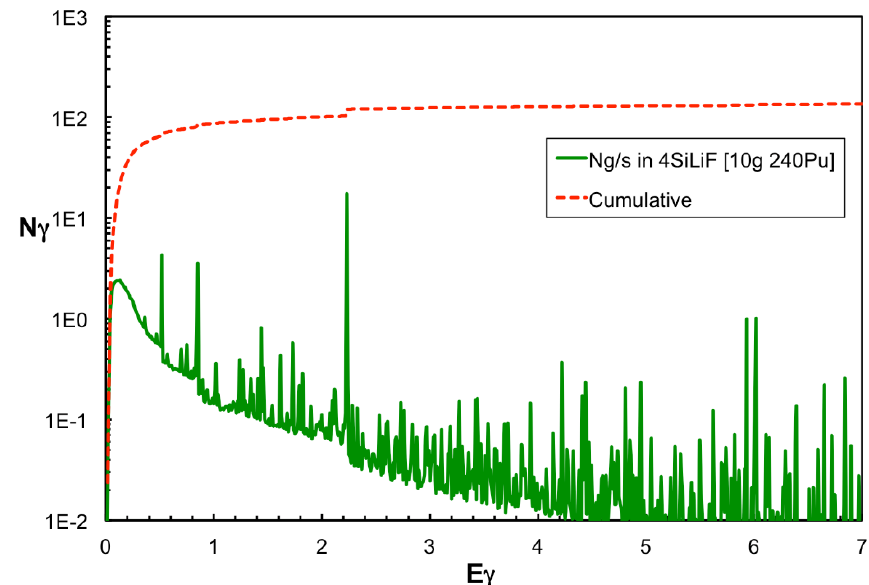
Figure 25. The simulated spectrum of the gamma rays impinging on the four SiLiF detectors (green line) and the corresponding cumulative distribution (red dotted line).